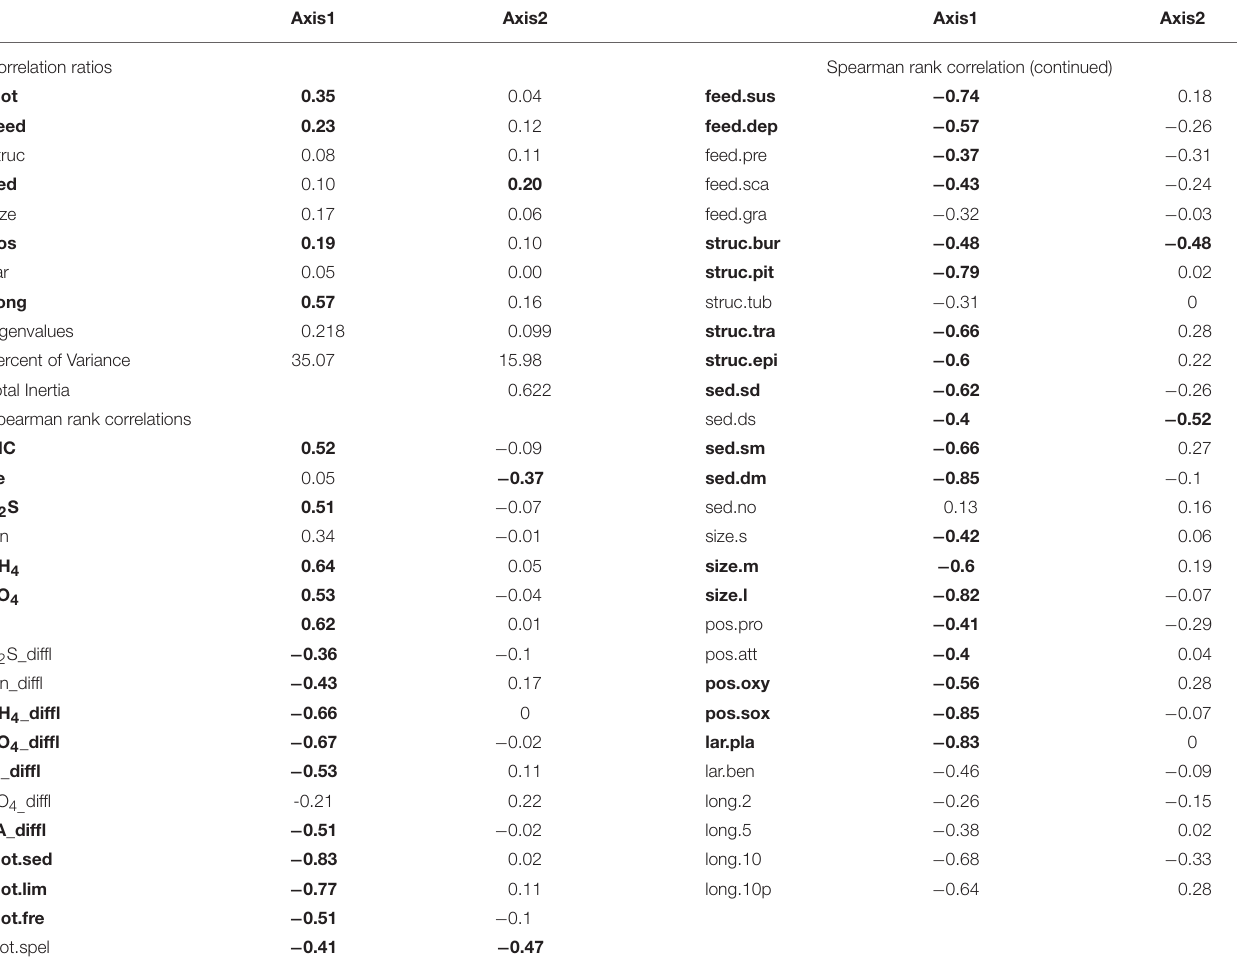
TABLE 3 | Correlation ratios of biological traits for the FCA ordination, that corresponds to the proportion of variance on each axis that can be explained by the trait modalities (abbreviation as in Table 2 ) within each trait. Axis1 Axis2 Axis1 Axis2 Correlation ratios Spearman rank correlation (continued) 0.35